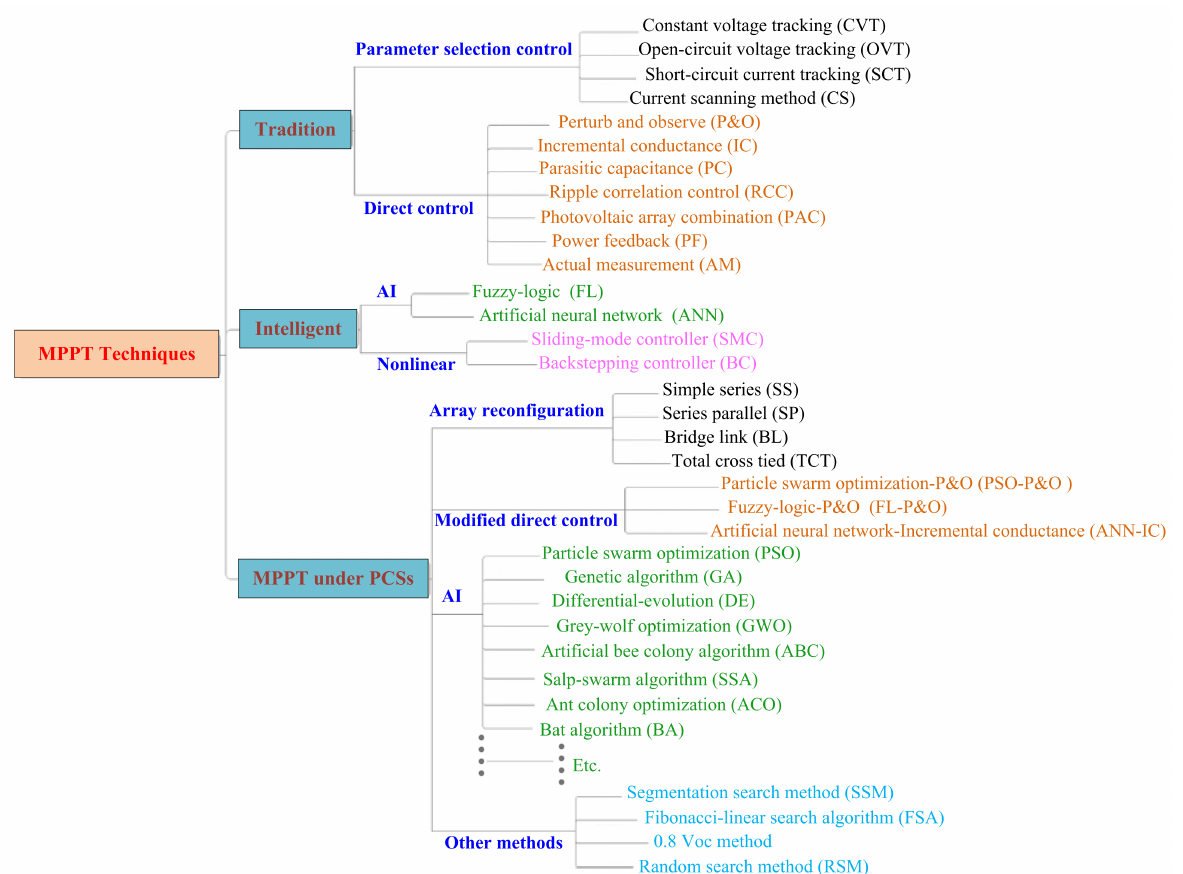
Figure 2. Classification of some common MPPT control methods